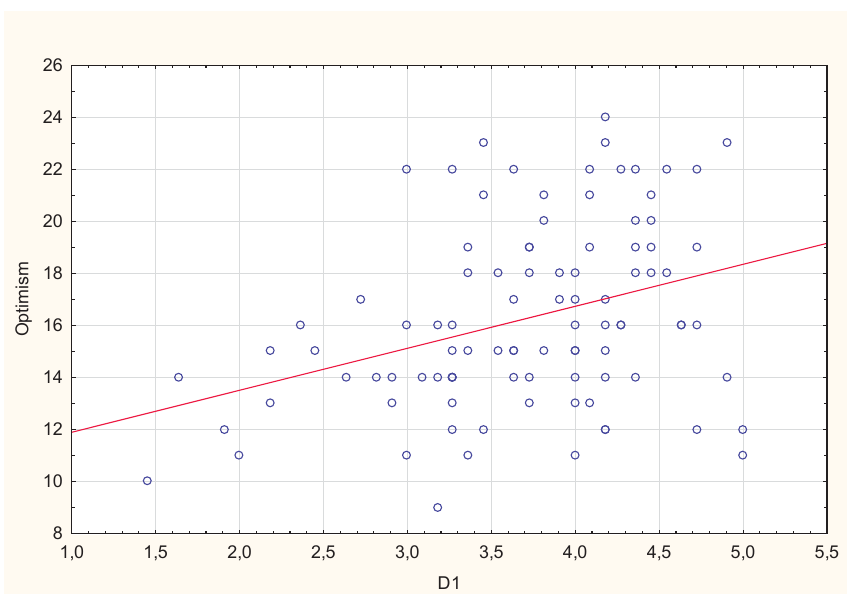
Figure 4. (cid:55)(cid:75)(cid:72)(cid:3)(cid:86)(cid:70)(cid:68)(cid:87)(cid:87)(cid:72)(cid:85)(cid:3)(cid:71)(cid:76)(cid:68)(cid:74)(cid:85)(cid:68)(cid:80)(cid:3)(cid:178)(cid:3)(cid:50)(cid:83)(cid:87)(cid:76)(cid:80)(cid:76)(cid:86)(cid:80)(cid:3)(cid:87)(cid:82)(cid:3)(cid:83)(cid:75)(cid:92)(cid:86)(cid:76)(cid:70)(cid:68)(cid:79)(cid:3)(cid:90)(cid:72)(cid:79)(cid:79)(cid:16)(cid:69)(cid:72)(cid:76)(cid:81)(cid:74)(cid:3)(cid:11)(cid:39)(cid:20)(cid:12)(cid:3)(cid:73)(cid:82)(cid:85)(cid:3)(cid:87)(cid:75)(cid:72)(cid:3)(cid:68)(cid:81)(cid:68)(cid:79)(cid:92)(cid:93)(cid:72)(cid:71)(cid:3)